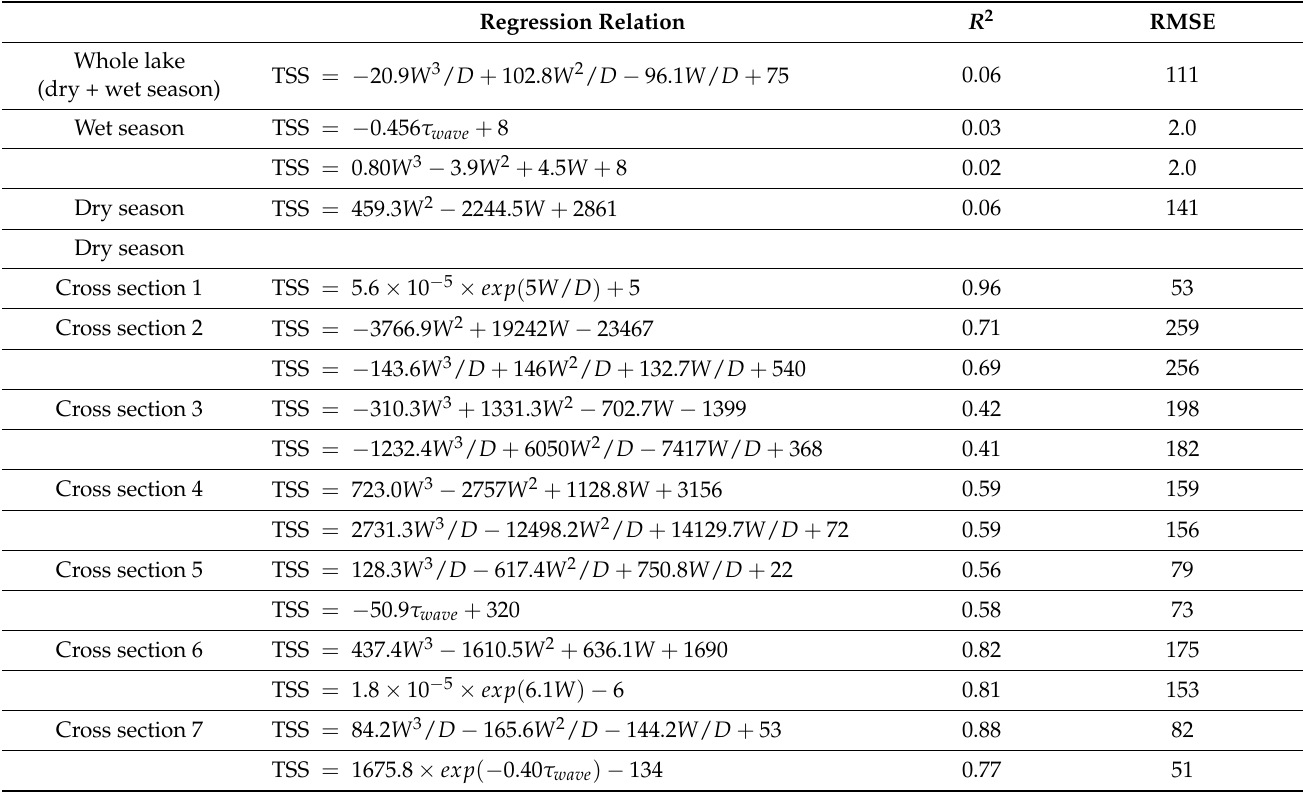
Table 4. Empirical relation for TSS in Tonle Sap Lake, Cambodia.